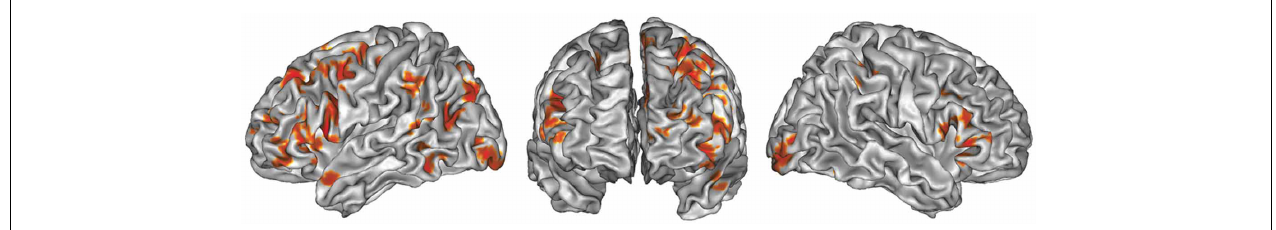
FIGURE 1 | ALE map of all foci, thresholded at a whole-brain cluster-level corrected p < 0 . 05. Activations are displayed on the surface rendering of the Colin27 template (Holmes et al., 1998) in the MNI space.